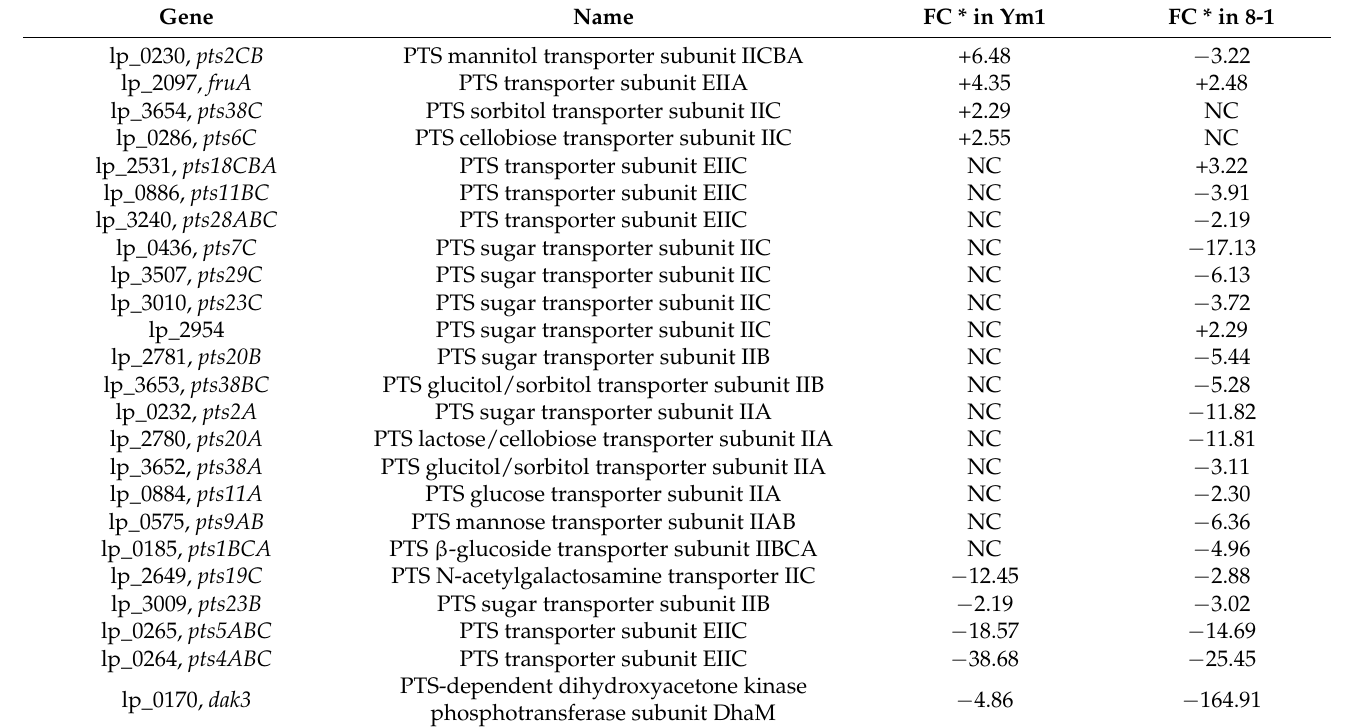
Table 2. Differentially expressed genes (DEGs) encoding PTS transporters in L. plantarum strains under butanol stress. Gene Name FC * in Ym1 FC * in